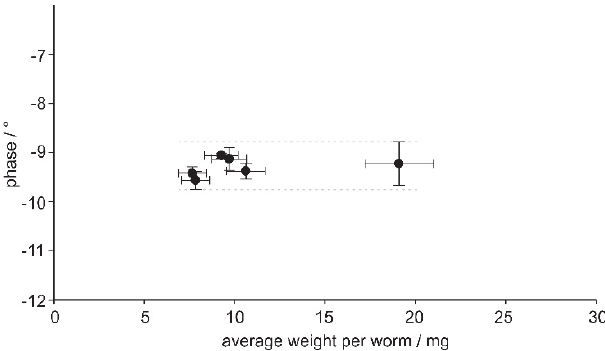
Fig. 7: Phase response per mg of worm for 6 groups of differently sized groups of worms at 90 kHz. Diets from left to right: TetraMin ® / starch mix COD/N=37; TetraMin ® / starch mix COD/N=56; TetraMin ® pure; Okara; soy meal; chlorella. Error bars are due to worm weight variation (abscissa) and measurement error (ordinate), respectively. The dotted grey lines are a visual aid showing the upper and the lower end of the measurement